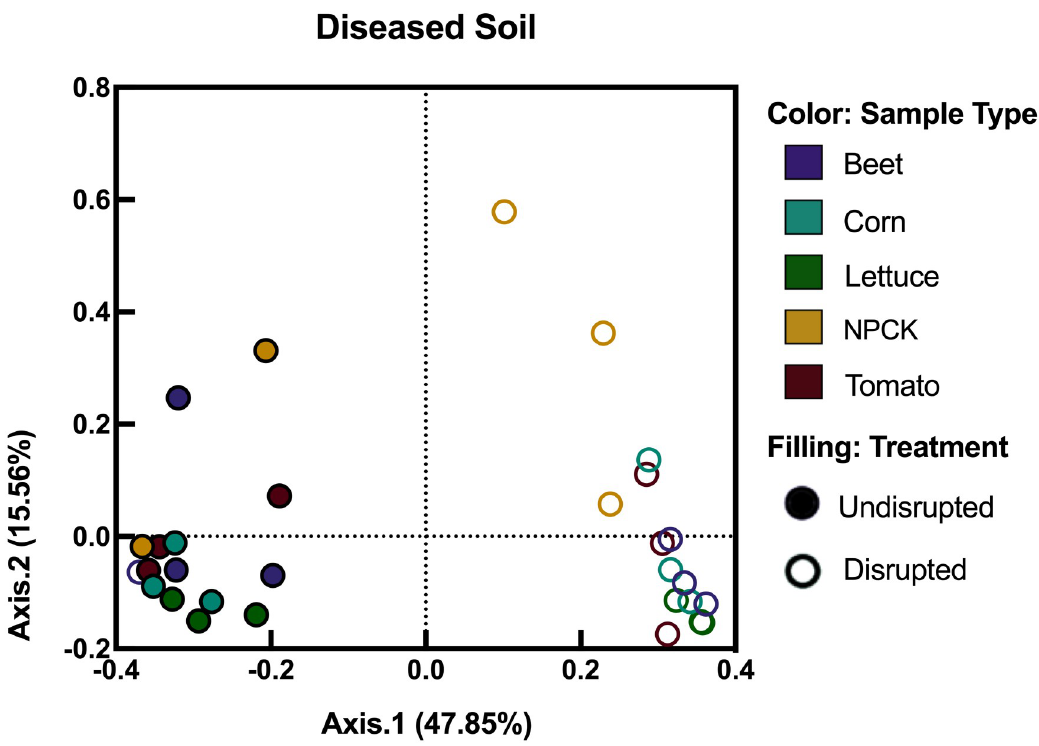
Fig 5. Principal coordinate analyses (PcoA) of rhizobacterial communities after crop growth in undisrupted and disrupted diseased agroecosystem soils. Colored circles indicate samples treated with disruption, whereas hollow circles indicate undisrupted soils, respectively. Purple, teal, green, yellow, or red color represents rhizospheric samples from beet, corn, lettuce, NPCKs or tomato samples, respectively. Figure created using GraphPad’s Prism (Vers. 8.2.1).